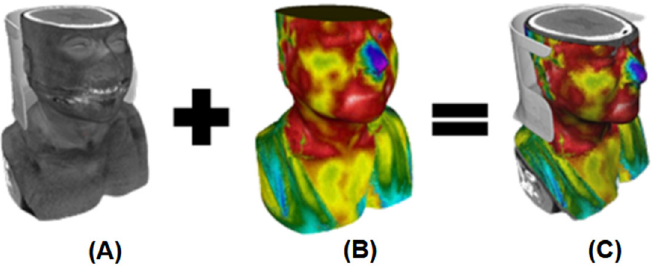
Figure 12. ( A ) 3D anatomy model generated from the 3D reconstruction (by the CT DICOM images). ( B ) 3D Thermal Model (obtained from the SfM methodology and its consequent thermal imaging projection onto the 3D outer bust model). ( C ) Combined registered 3D complete model—represented at the common coordinate system.